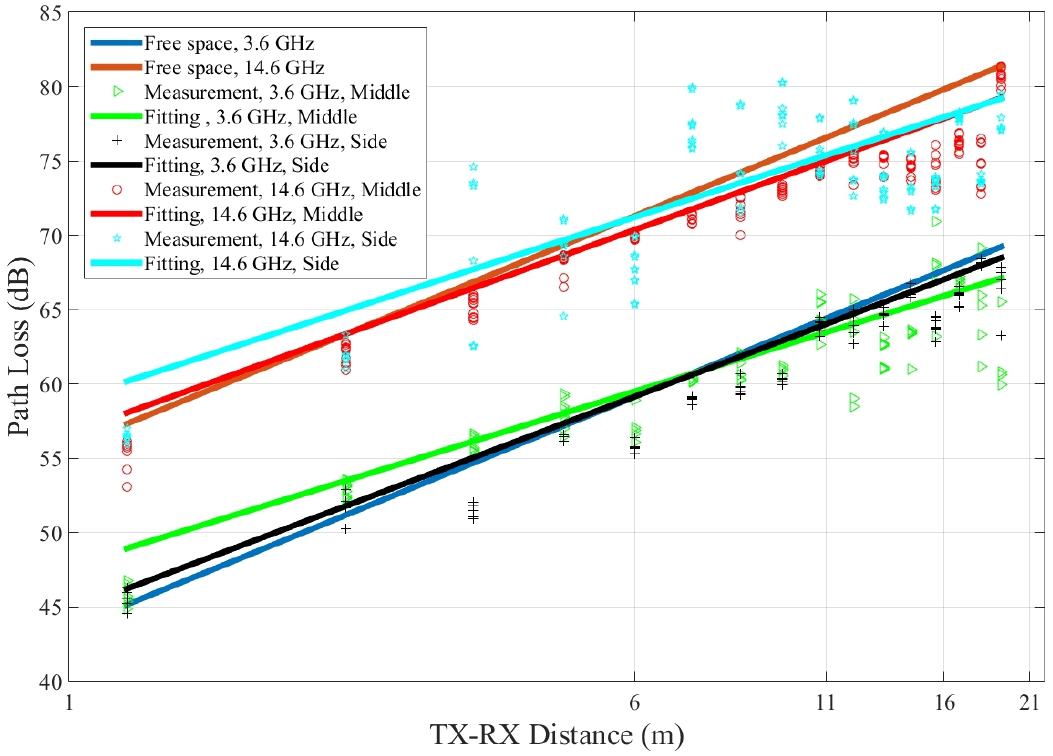
Figure 7. (color online) Path loss versus link